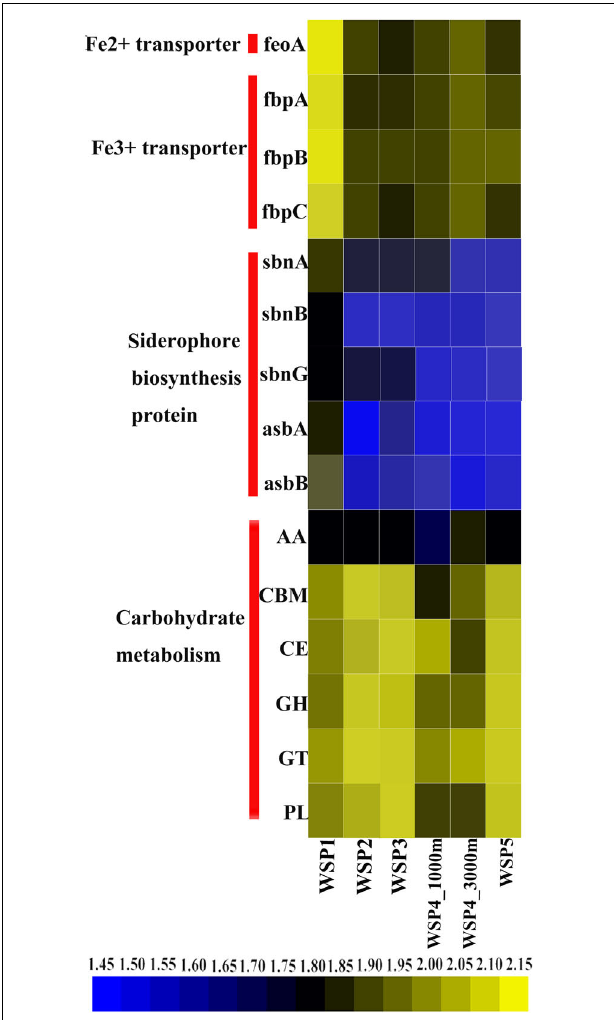
FIGURE 8 | The relative abundance of carbohydrate metabolism modules and iron metabolism related genes in each sample. Abundances were based on the calculation of the genes’ coverage, and the abundance value was first log scaled and then